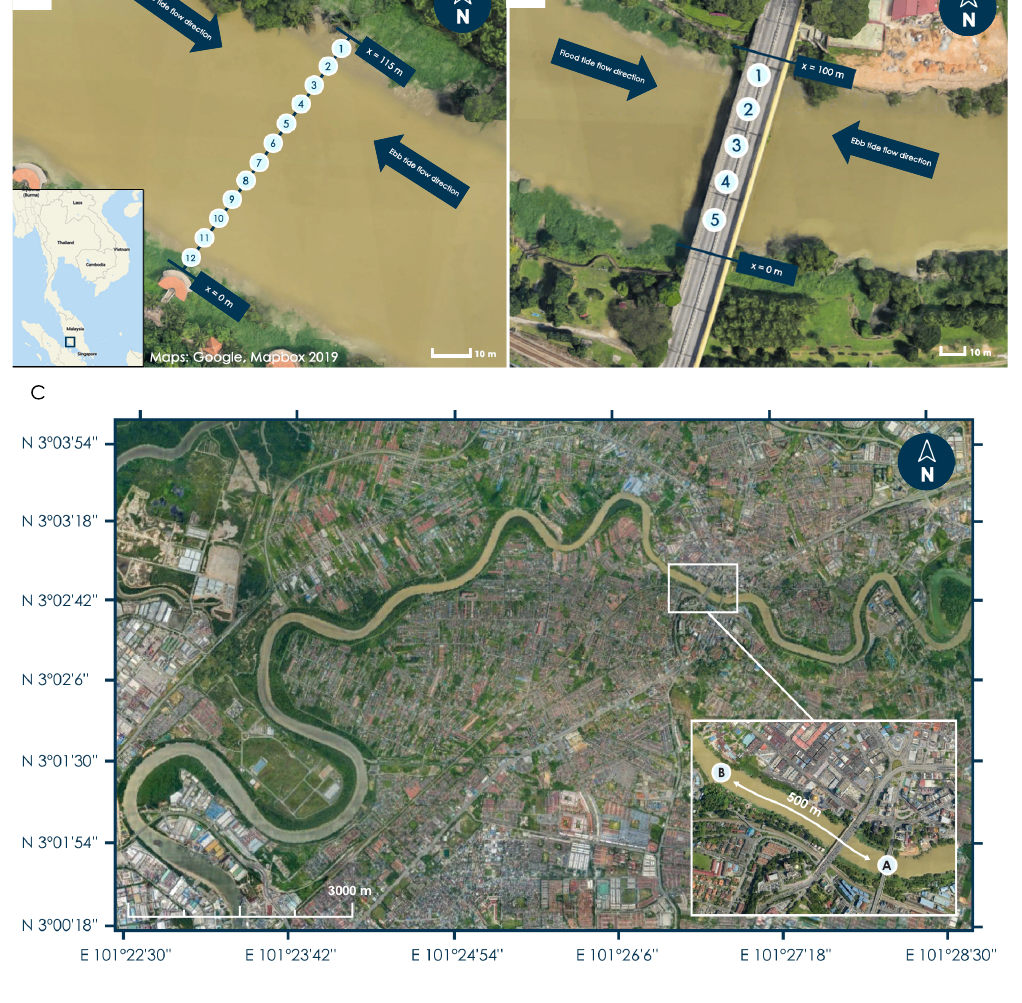
Figure 2. ( A ) Measurement locations along a transect at the case study site for the UAV-based measuring procedure on Klang River, Malaysia. Measurement location numbering starts at the opposing riverbank relative to the take-off location. ( B ) Overview of the measuring locations along the Jalan Tengku Kalana bridge in the city of Klang. ( C ) Overview of the Klang River and the locations of the observation sites relative to each other. “A” indicates the visual counting observation site at the Jalan Tengku Kalana bridge, and “B” indicates the drone observation